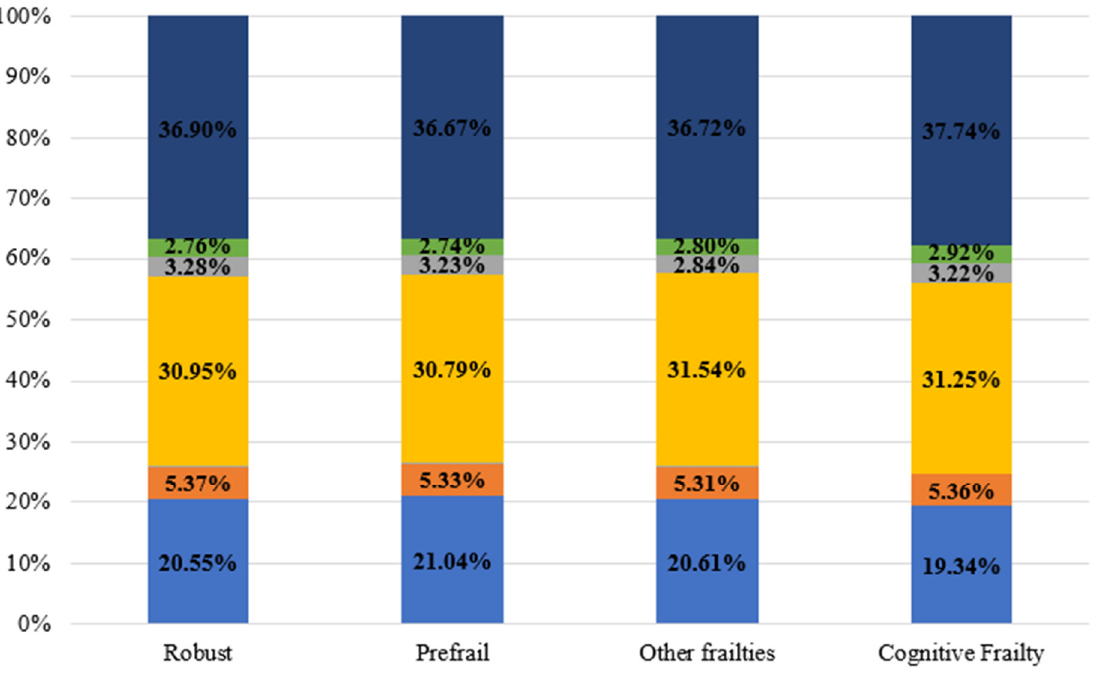
Figure 3. Type and percent of out-of-pocket payments for care during past six